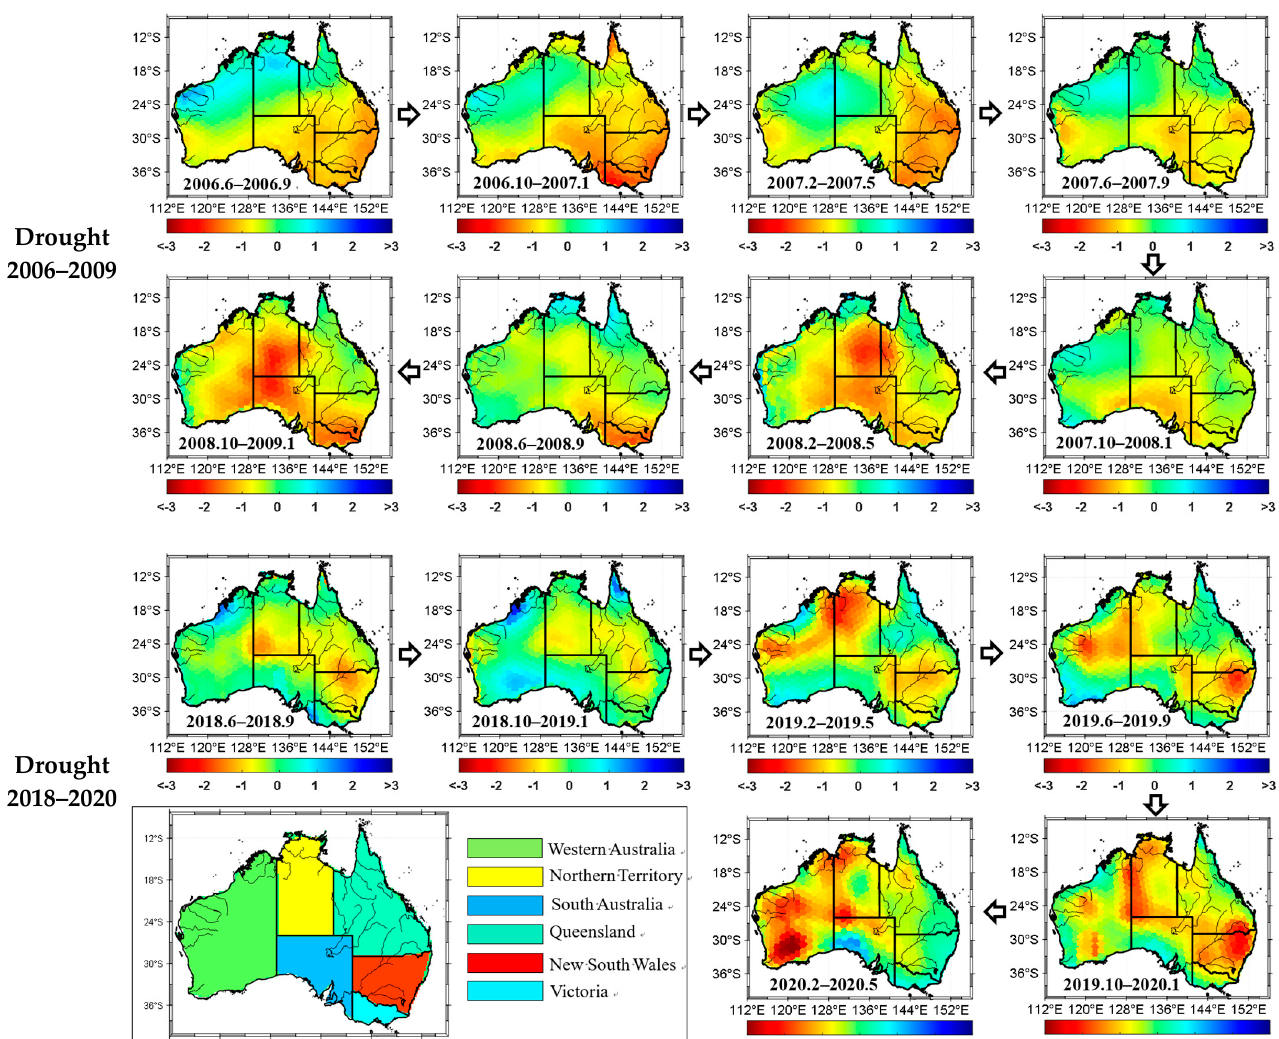
Figure 4. Spatial distributions of the evolution for droughts reflected by TSDI during Drought 2006–2009 and Drought 2018–2020. (The sub-figures of mean TSDI are calculated every four months, the red tone represents drought, and the blue tone represents wet condition).